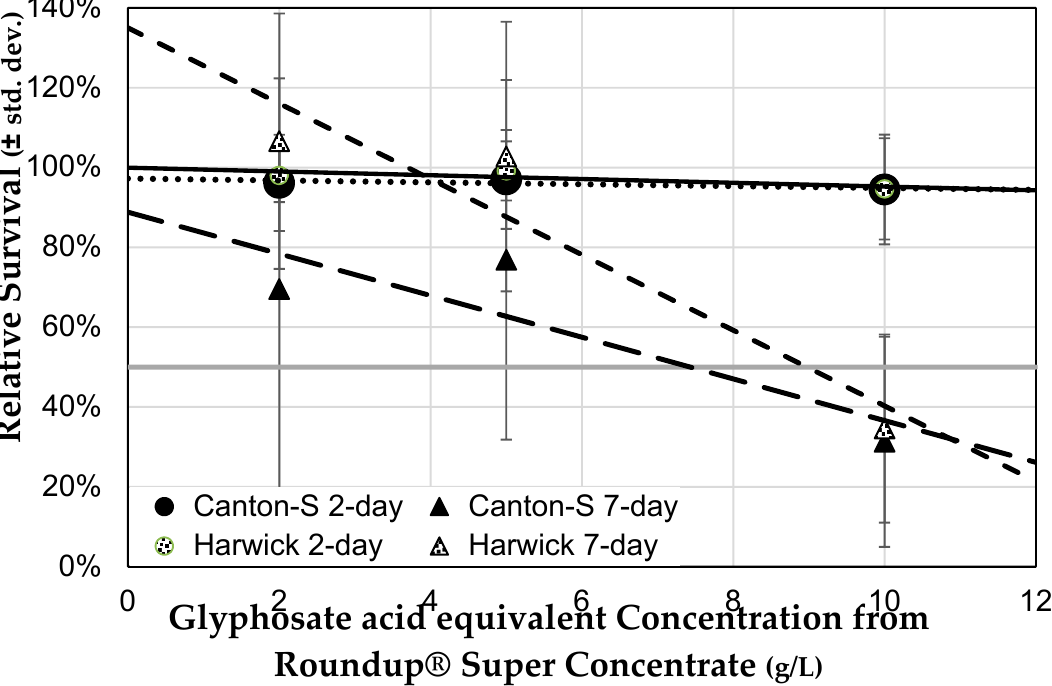
Figure 5. Effect of the genetic background on sensitivity to Roundup ® concentration. Survival of mixed-sex groups after two days and seven days of Roundup ® exposure (nine days and 14 days post eclosion) at three concentrations of Roundup ® Super Concentrate in food medium, compared to the survival of flies of the same age and strain exposed to control medium ( ± std. dev.). The light grey line indicates 50% survival and can be used to determine LC 50 for seven-days of exposure.